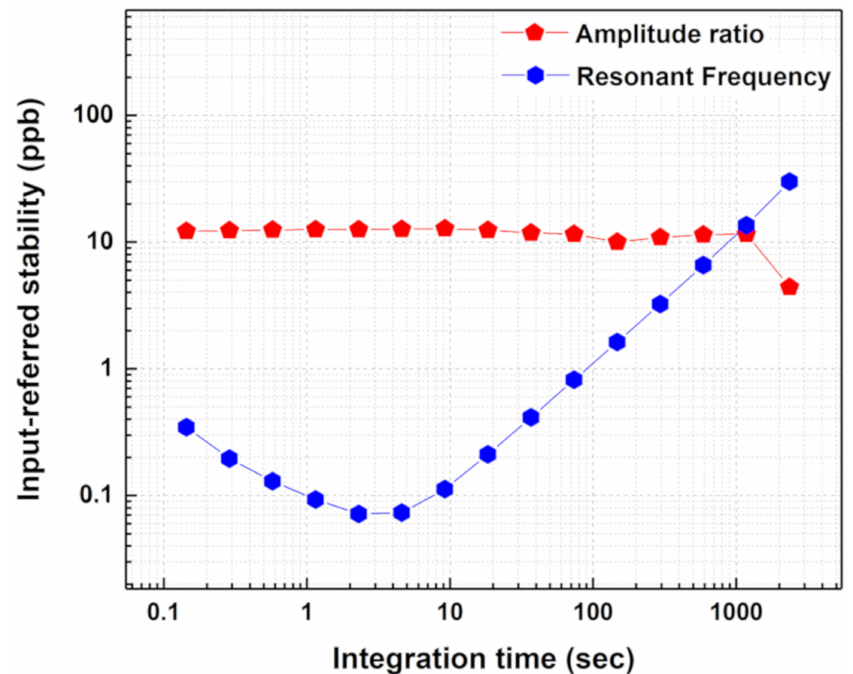
Figure 12. Estimated input referred stability utilising the sensitivity values indicate that the amplitude ratio output metric is suitable for long-term